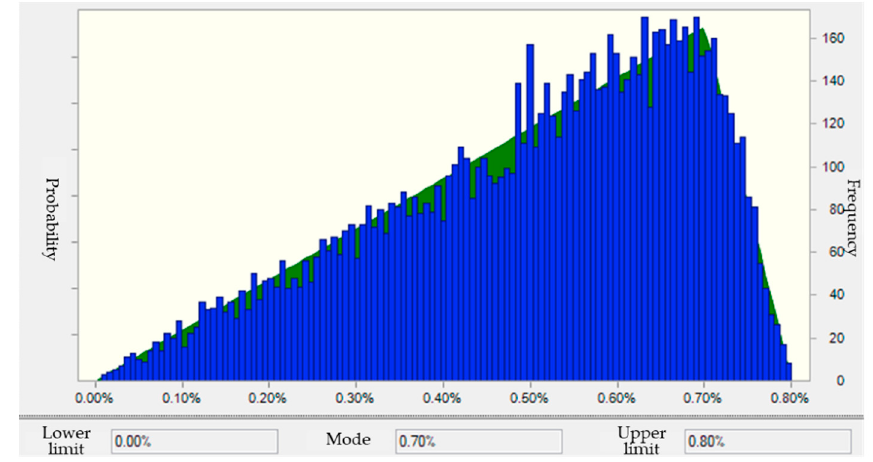
Figure 8. System degradation rate probability distribution (triangular distribution).